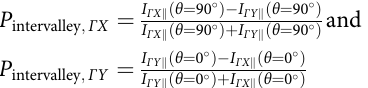
Table 1 Character table for C 2v point group for k points along Γ X (top) and Γ Y (bottom)